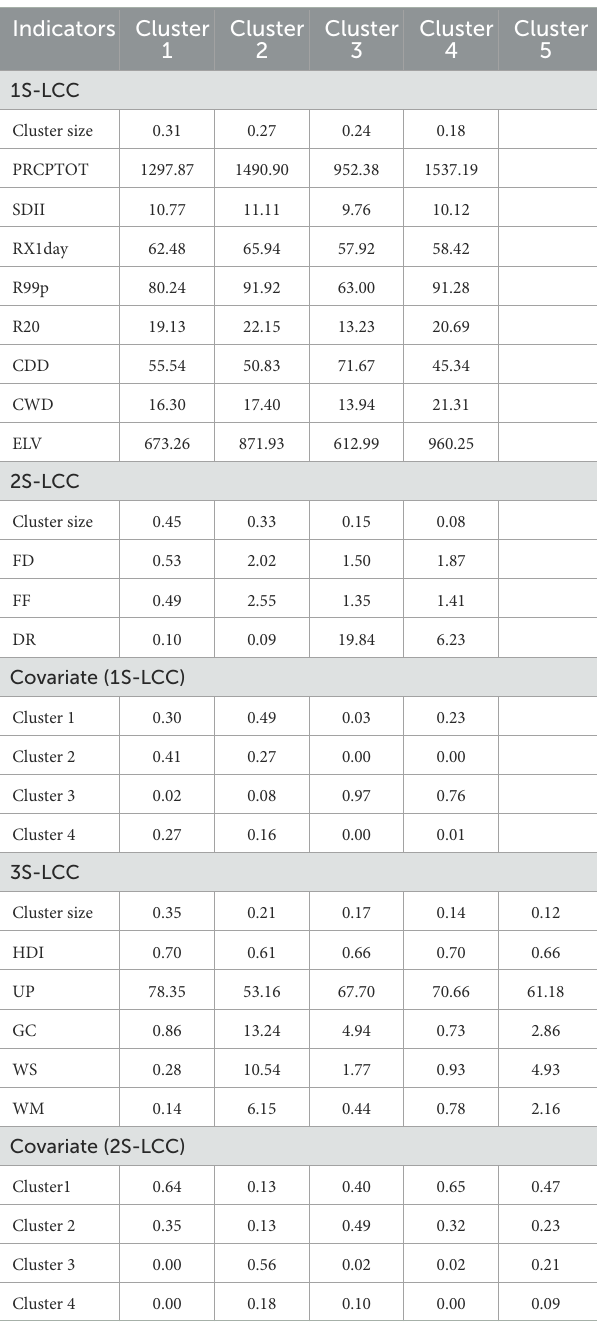
TABLE 3 Estimates of conditional averages for indicators and covariates regarding the latent class profiles of extreme rainfall events, rainfall-related disasters, and sociodemographic attributes in Minas Gerais,